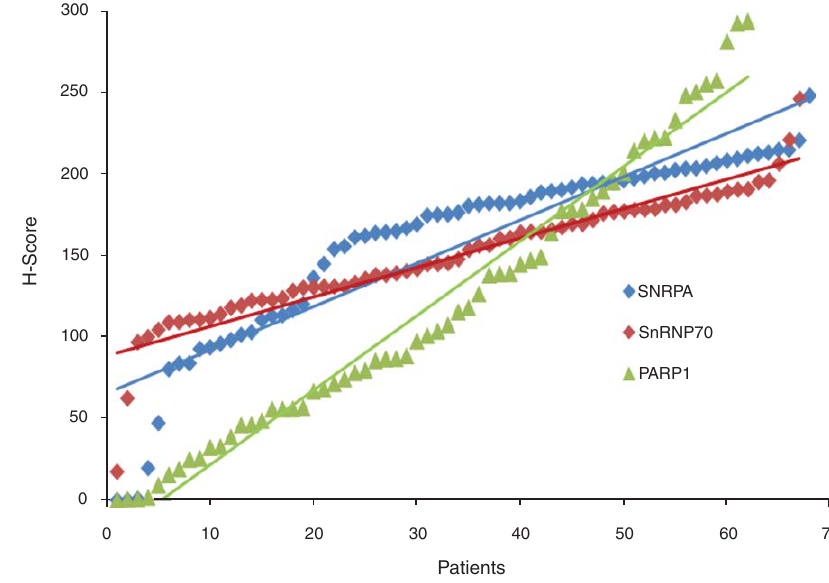
Fig. 2. Dynamic range of expression for 2 candidate calibrators, SnRNP70 and SNRPA, relative to test biomarker PARP1. Ordered patient ranking is depicted for H-scores derived from human breast cancer TMA staining and scoring along with added trend